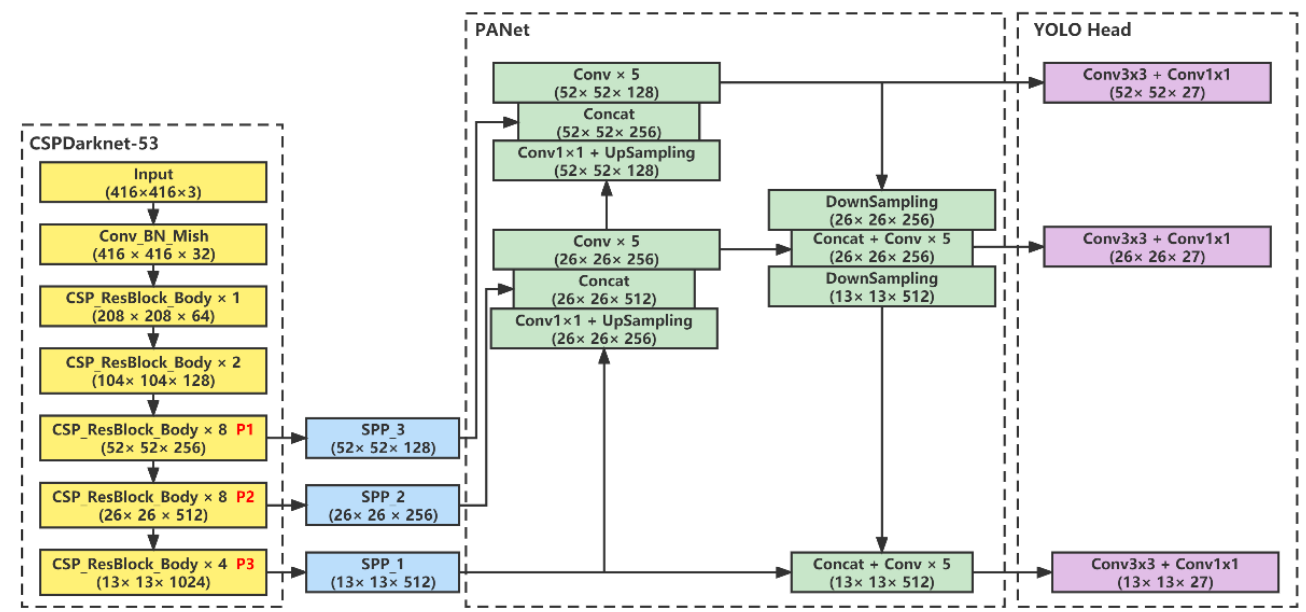
Figure 7. Architecture of the improved YOLOv4.